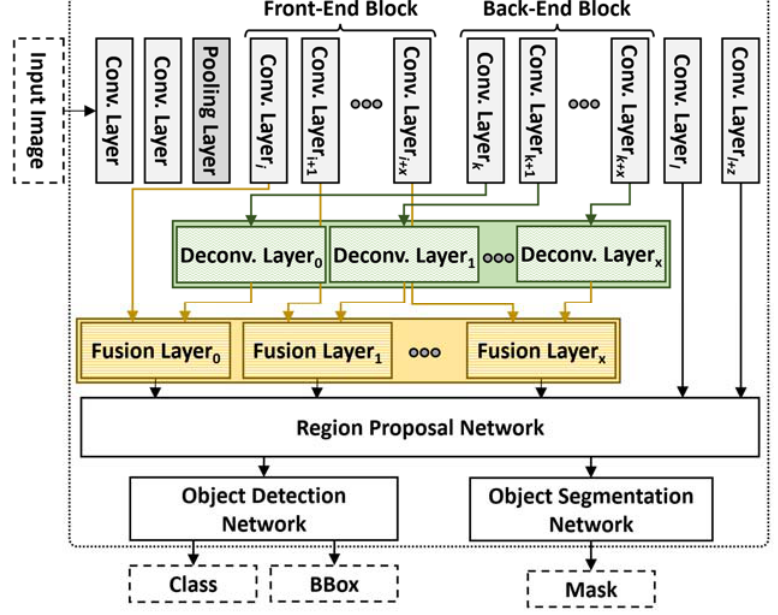
Figure 6. Structure of refined mask R ‐ CNN for small ‐ sized objects.